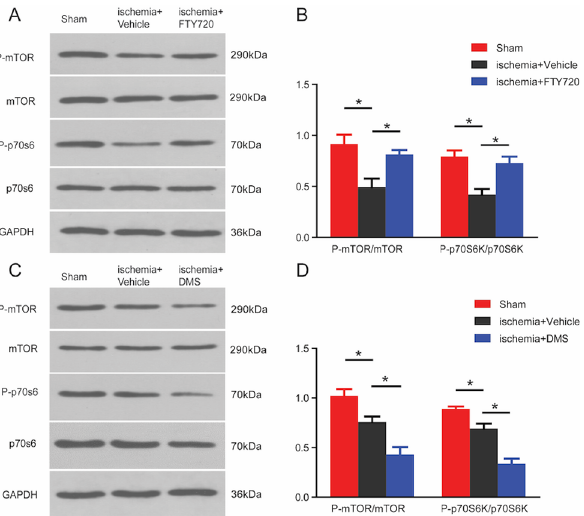
Fig 7. The S1P signaling pathway modulates the mTOR/p70S6K pathway following photothrombic ischemic stroke (PT). A, Representative western blots of p-mTOR/t-mTOR and its downstream target p- p70S6K/t-p70S6K at 3days after PT. B, Quantification of the results from panel A. C, The impact of the SphK inhibitor,DMS, on the expressionof the mTOR/p70S6K signalling pathway was assessed by western blotting. D, Quantification of the results in panel C. (n = 4 for each group, # p < 0.05 vs. sham group, * p < 0.05 vs. ischemia+vehiclegroup, one-wayANOVA with Tukey post hoc test).